Question: How would you classify this visualization?
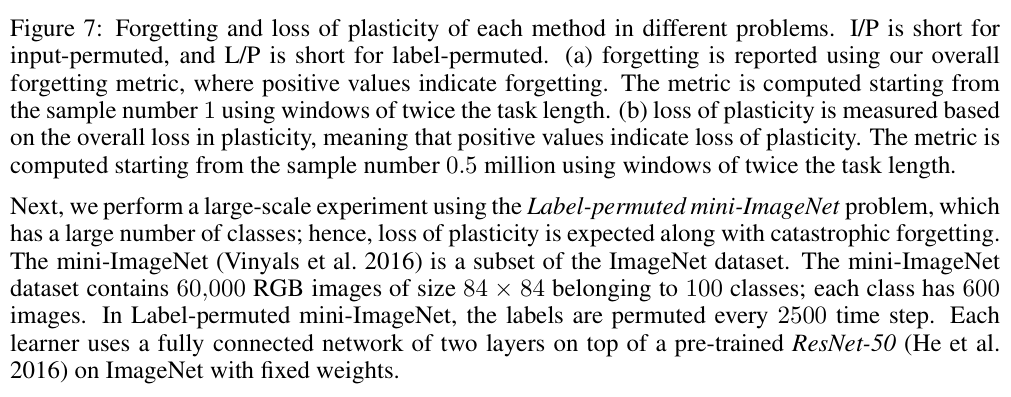
Answer: line